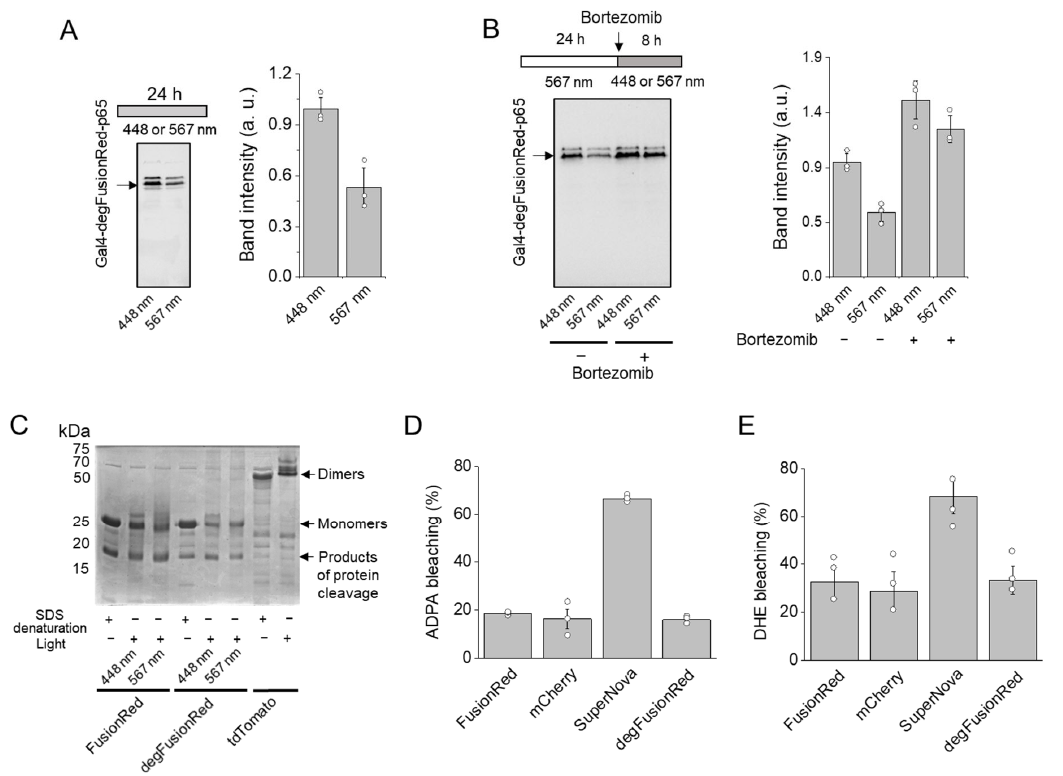
Figure 3. Analysis of the mode of action of degFusionRed. ( A ) Effect of 567 nm light on the amount of Gal4-degFusionRed-p65 transcription factor studied via Western blot in HEK293 cell lysate. Cells were illuminated with 448 nm or 567 nm light for 24 h after transfection. The right graph shows the quantification of intensities of the Western blot Gal4-degFusionRed-p65 bands. ( B ) Effect of bortezomib on Gal4-degFusionRed-p65 transcription factor in HEK293 cells evaluated via Western blot. After 567 nm cell illumination for 24 h, cells with or without the addition of bortezomib were treated with 448 nm light or kept under 567 nm for an additional 8 h. The right graph shows the quantification of intensities of the Western blot Gal4-degFusionRed-p65 bands. ( C ) Semi-native PAGE gel analysis of FusionRed, degFusionRed and tdTomato dimeric control purified from bacteria after 8% denaturation with 8% SDS, 488 nm or 567 nm illumination. ( D ) Singlet oxygen production in purified FusionRed, mCherry, SuperNova and degFusionRed protein samples determined via photobleaching of ADPA. ( E ) Superoxide production in purified FusionRed, mCherry, SuperNova and degFusionRed protein samples determined via photobleaching of